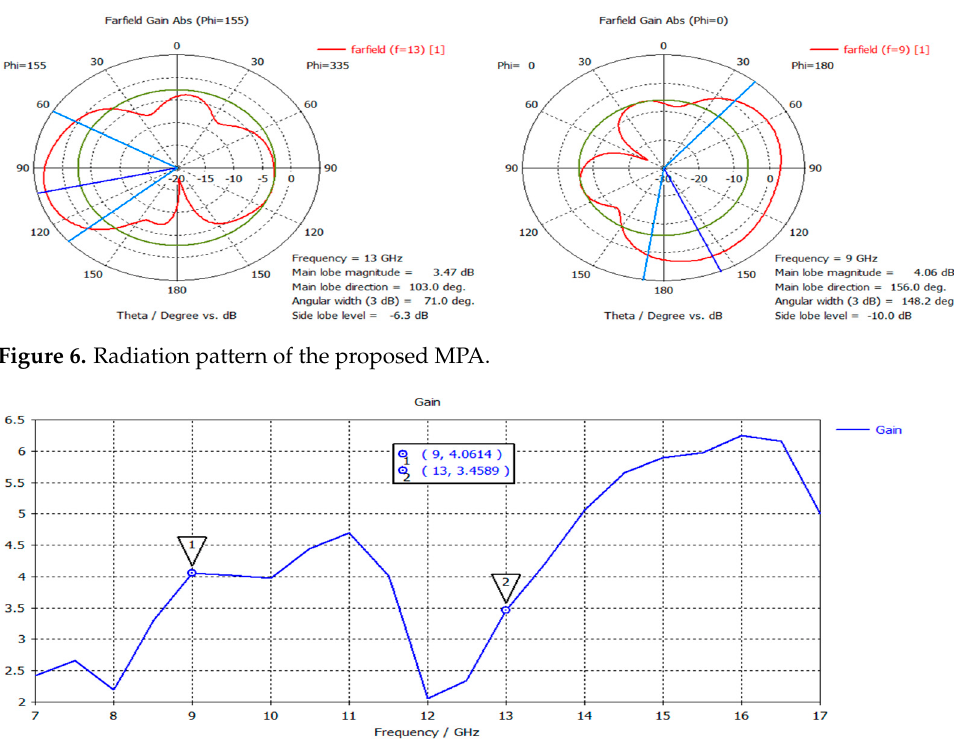
Figure 6. Radiation pattern of the proposed MPA.